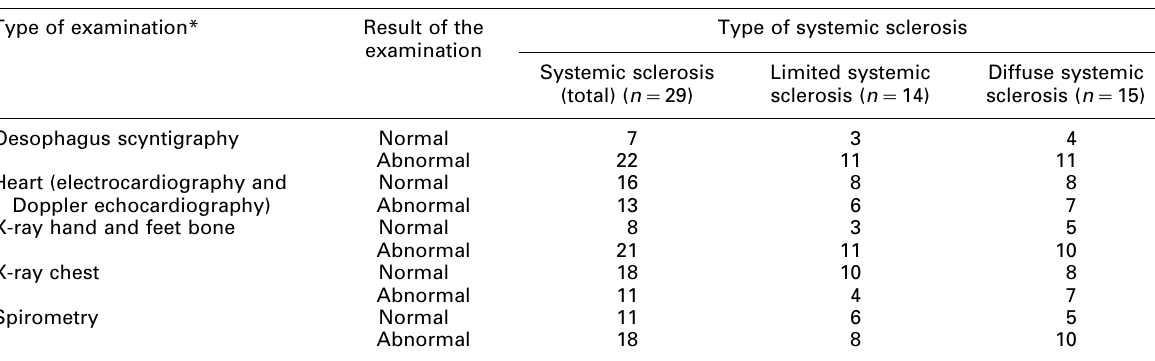
* Oesophagal scyntigragraphy abnormalities: retarded passage in the lower and/or central part of the oesophagus. Cardio-vascular abnormalities: tendency to tachyarrhythmias, lower potentials of different parameters describing variability of cardiac rythmus or conduction system abnormalities, ventricular arrhythmia, silent ischaemic episodes, diastolic left ventricular disturbances, valvular lesions. Changes in osteo-articular system: juxta-articular demineralization, joint space narrowing in digitals. X-ray chest changes: symmetrical fibrosis of the lung base and ‘honey-comb’ picture. Spirometry: lung function disturbances of restrictive, obstructive or mixed type.